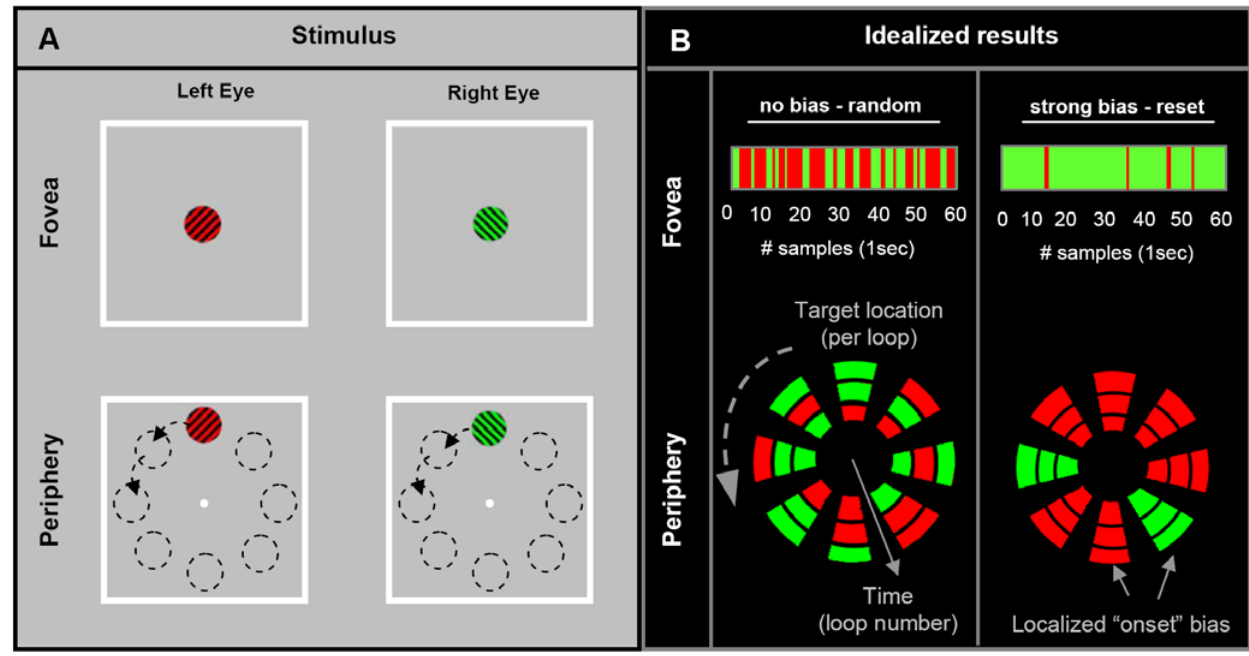
Figure 1. Illustration of stimulus and data presentation method. (A) In experiment 1, binocular rivalry was induced with foveal presentation of red and green orthogonal gratings to the left or right eye respectively. The rivaling targets were red and green sinusoidal grating patches that subtended 2.5 u of visual angle. The gratings had a spatial frequency of 1.6 cycles/deg oriented obliquely at either 45 u or 135 u . Targets were presented for either 60sec of continual presentation or for 60 6 1sec presentations over 600 sec (i.e. 1sec on 9sec off). In experiment 2, the same targets were presented in one of 8 locations spaced equally around a circular path with a radius of 4.5 u around a 0.3 u central fixation point. During the intermittent stimulus conditions targets were presented for 1sec with an inter-stimulus interval 250ms (all 8 locations visited every 10sec). In both conditions the targets were presented on a gray background within a 13.5 u white square frame 0.2 u thick. (B) Schematic illustration of results for an idealized case of random and strongly biased perceptual dominance (note that any switch in perception is only temporary, suggesting the dominance reflects an onset bias rather than stabilization). For foveal rivalry the data are graphically represented as a sequence of 60 adjacent colored bars corresponding (from left to right) with the perceptual dominance for each of the 60 6 1sec presentation (in the intermittent case the gap interval is not depicted). In experiment 2, perceptual dominance at each location is illustrated by a color patch corresponding to each of the 8 peripheral target locations. Each successive target loop is represented in increasingly outward rings. In this way, each color patch represents the subject’s perceptual dominance at a single point in time and space for the entire trial. The left column represents idealized case for random allocation of dominance, while the right column shows complete localized